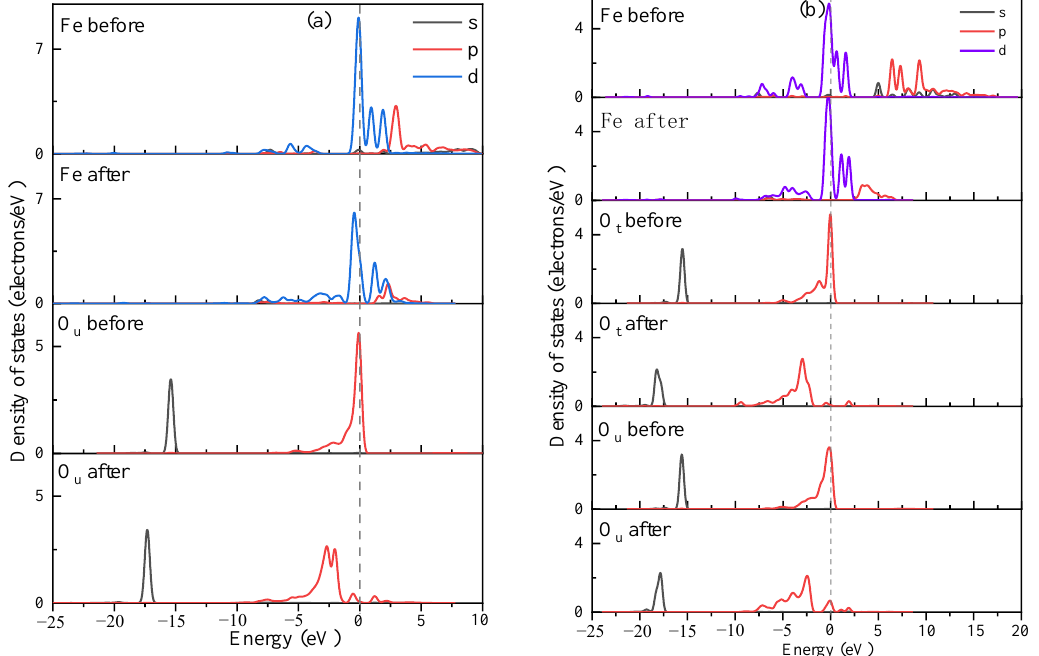
Figure 9. Fe and O u PDOS in forms C ( a ) and Fe, O l , and O u PDOS in forms D ( b ). Fermi face is the line at 0 eV.